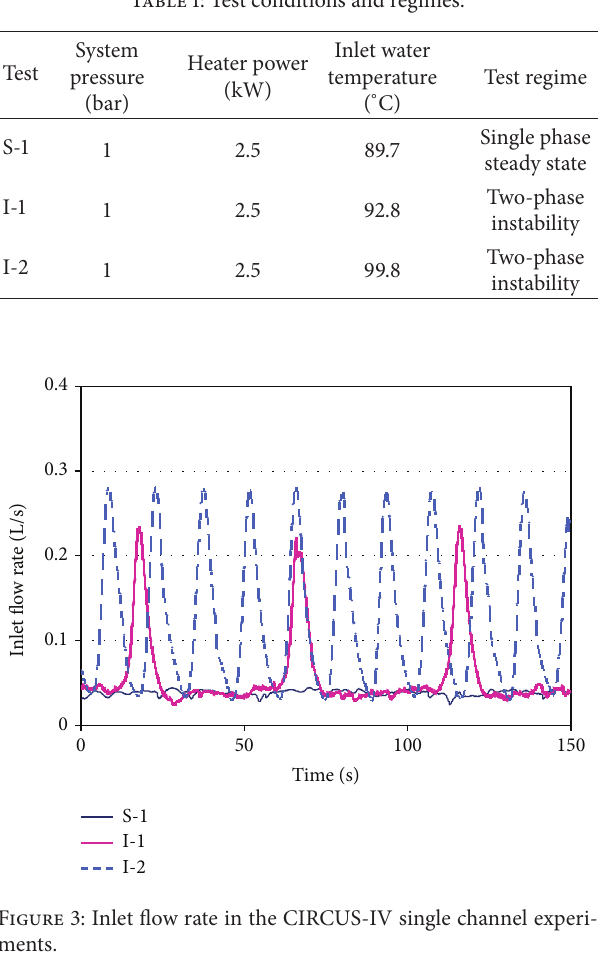
Table 1: Test conditions and regimes.